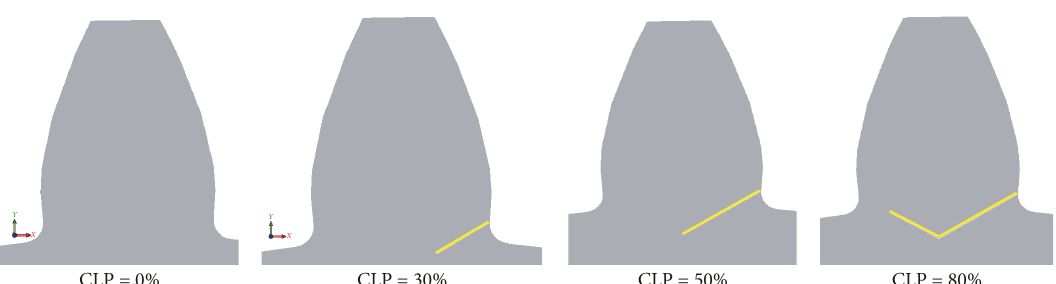
Figure 7: Crack propagation path for different crack extents.